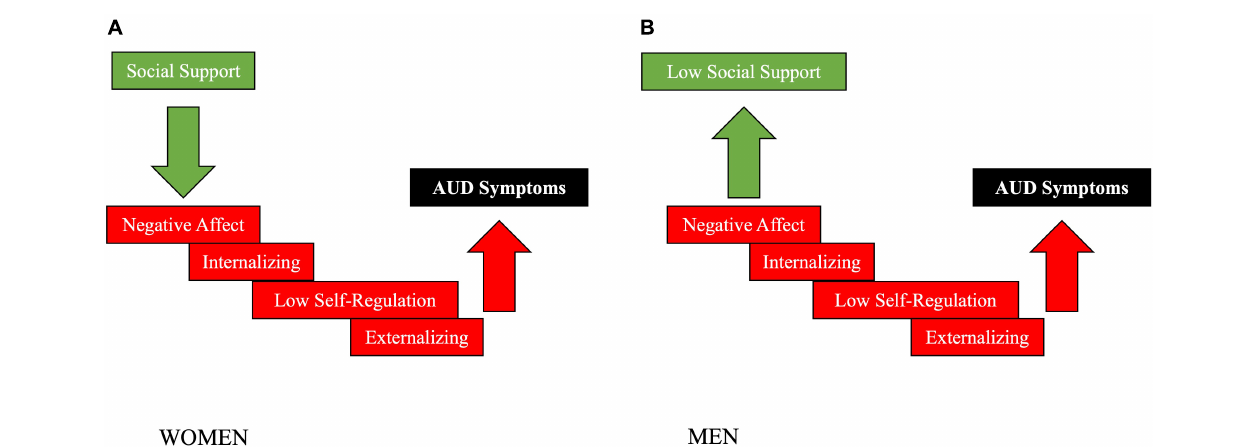
FIGURE 1 | Summary of our empirical gender-specific causal pathway analysis on the role of social support in AUD in women (A) vs men (B) (see Supplementary Material for details on the approach and results). Causal modeling suggested that increased social support had a buffering effect on negative affect, internalizing and externalizing mental health symptoms, lack of self-regulation and AUD symptom severity in women, but not men. In men, in contrast, negative affect, mental health symptoms and a lack of self-regulation dysregulated both AUD symptom severity and the availability of social support. These novel results support the existing literature by demonstrating that social support plays a larger role in modulating AUD symptom severity in women compared to